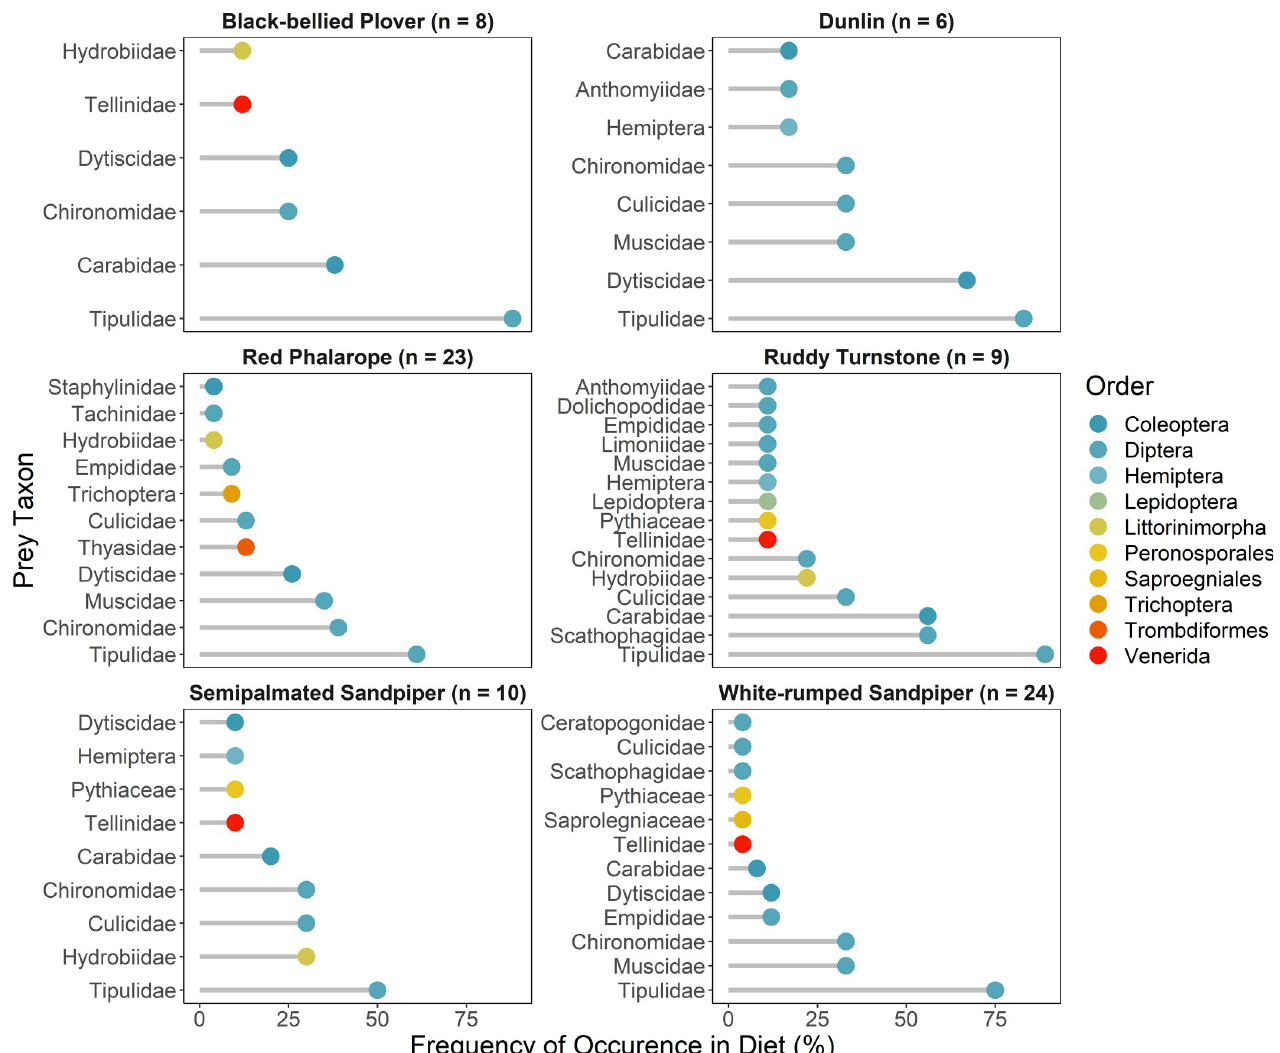
Fig 4. Frequency of occurrence of invertebrate families identified in fecal samples of each shorebird species using DNA metabarcoding.